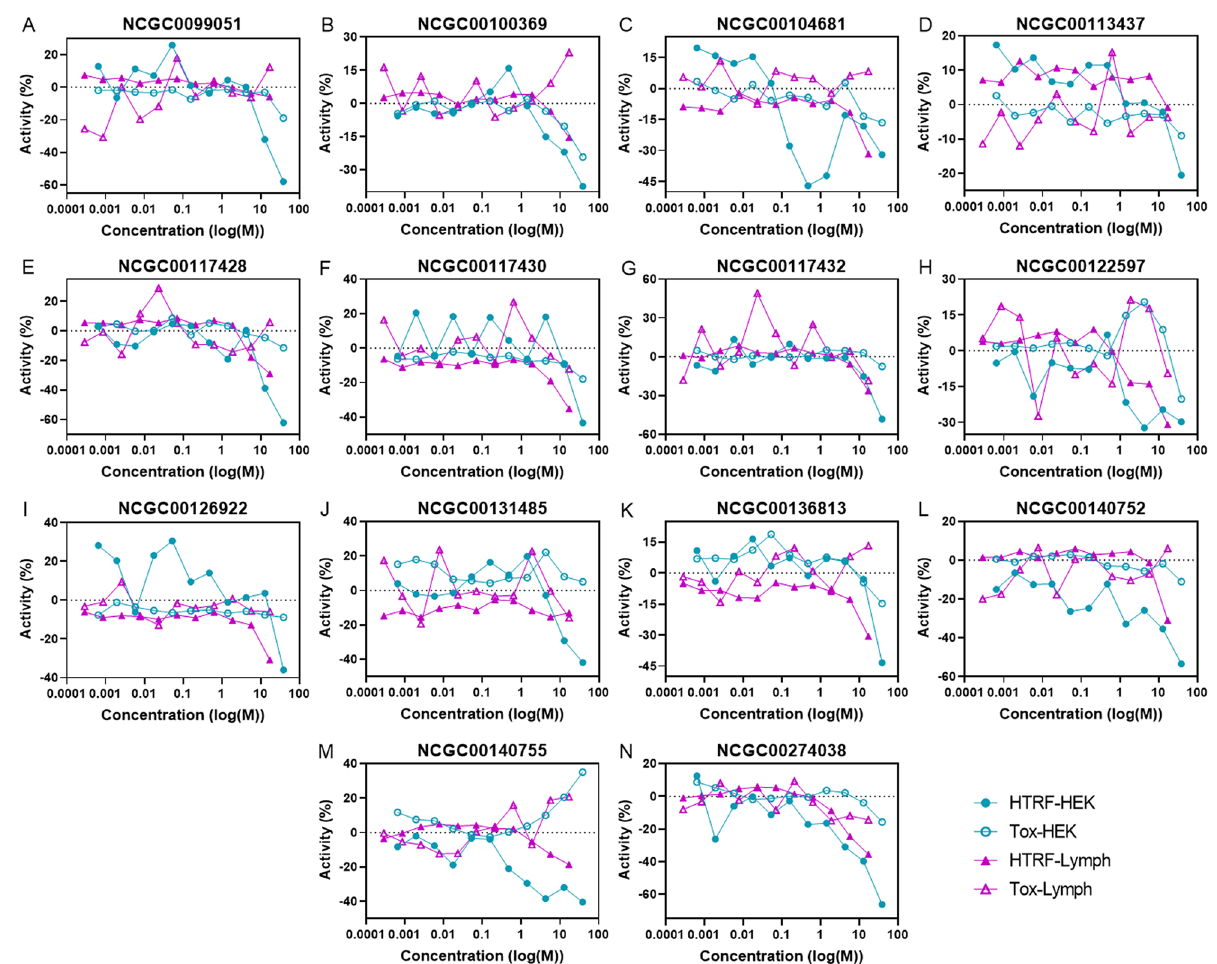
Figure 3. Huntingtin protein-lowering and cytotoxicity assays in HEK293 cells and HD lymphoblasts of 123 compounds that altered HTT or HTT-AS promoter activity. 14 compounds (A–N) out of 123 tested lowered huntingtin protein in either HEK 293 cells (HTRF-HEK) or HD Lymphoblasts (HTRF-Lymph) based on an HTRF assay and were non-toxic according to ATP-based cytotoxicity assays (Tox-HEK; Tox-Lymph). Each compound was screened at 10 concentrations (HEK293 screen, highest concentration = 38 μM, with 1:3 dilutions; Lymphoblast screen, highest concentration = 17 μM with 1:3 dilutions; single well per concentration). Compounds were chosen based on active CRCs for huntingtin lowering (− 1/− 2/− 3) and inactive CRCs for cytotoxicity (≥ 4). Values are normalized to measurements in untreated HEK293 and HD lymphoblast well as evaluate the effectiveness of potential therapeutic agents 45,46 . An ATP-measuring assay was performed in parallel using the same concentration range to determine compound toxicity. A total of 17 compounds strongly lowered huntingtin protein levels as measured by the Homogeneous Time- Resolved Fluorescence (HTRF) assay, and evaluated by CRCs (− 1.1/− 1.2/− 2.1/− 2.2): 10 were active in HEK293 cells, 4 in HD lymphoblasts, and 3 in both cell lines. After eliminating toxic compounds, 14 were classified as active (Table 4; Fig. 3); 10 in HEK293 cells only, 6 in HD lymphoblasts only, and 2 compounds in both cell lines. Of the two compounds that lowered huntingtin protein in both cell types, one (NCGC00274038) was a hit derived from the HTT-AS screen, and one (NCGC00104681) from the HTT screen. Tertiary screen: huntingtin protein lowering in stem cell and neuronal HD lines. 12 out of the 14 compounds active compounds in the HTRF assay above were further tested in human embryonic stem cells (hESCs) from an HD patient (Charles River, long allele = CAG 48 ) and cortical neurons differentiated from an HD induced pluripotent stem cell (iPSC) line (Evotec, long allele = CAG 72 ). Two compounds were excluded due to hazardous material transportation restrictions or limited supplies. Cortical neurons were treated with compound for seven days at 10 doses (30 μM with 1:3 dilutions). A FRET-based assay was used to assess the capacity of each compound to lower mutant huntingtin, with an ATP- based cell viability assay run in parallel. One compound (NCGC00274038) exhibited some lowering of mHTT at concentrations that did not alter ATP levels (Fig. 4A,B). However, it also lowered Tau as assayed by FRET, indicating a lack of specificity. HD hESCs were treated with compound at 10 doses (30 μM with 1:3 dilutions). Both mutant and total huntingtin were measured, as well as protein kinase B (Akt) to assess specificity of action.